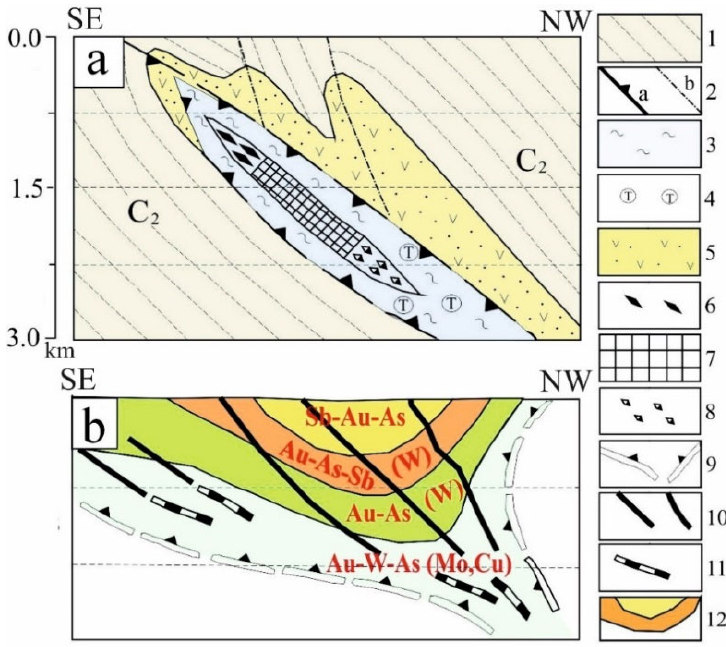
Figure 10. Location map of deposits in the Bakyrchik ore field (using unpublished data of V.I. Tikhonenko).